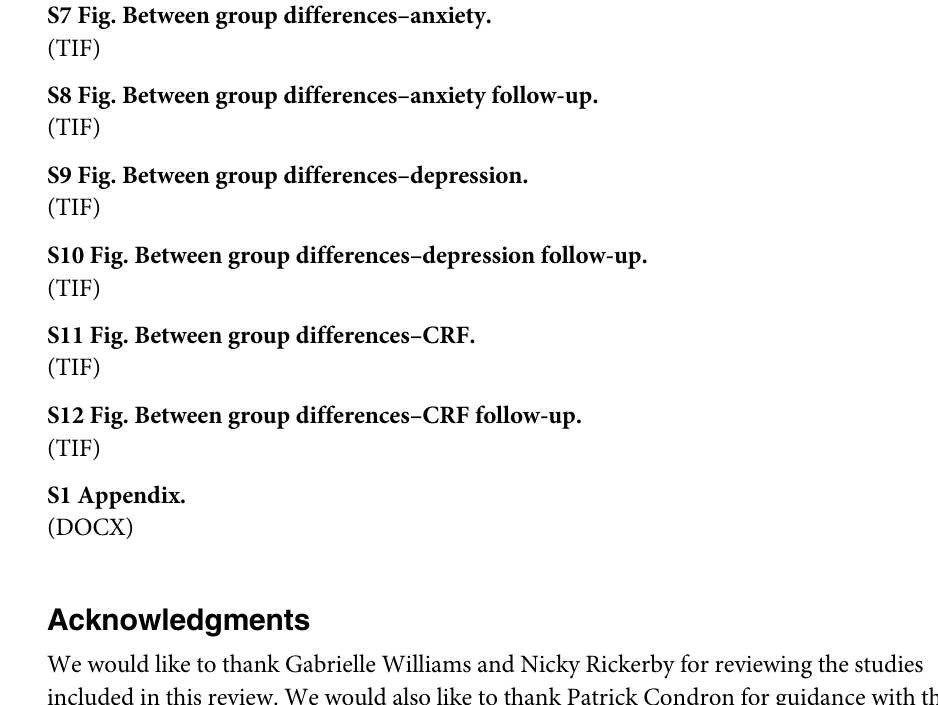
S7 Fig. Between group differences–anxiety. (TIF) S8 Fig. Between group differences–anxiety follow-up. (TIF) S9 Fig. Between group differences–depression. (TIF) S10 Fig. Between group differences–depression follow-up. (TIF) S11 Fig. Between group differences–CRF. (TIF) S12 Fig. Between group differences–CRF follow-up.